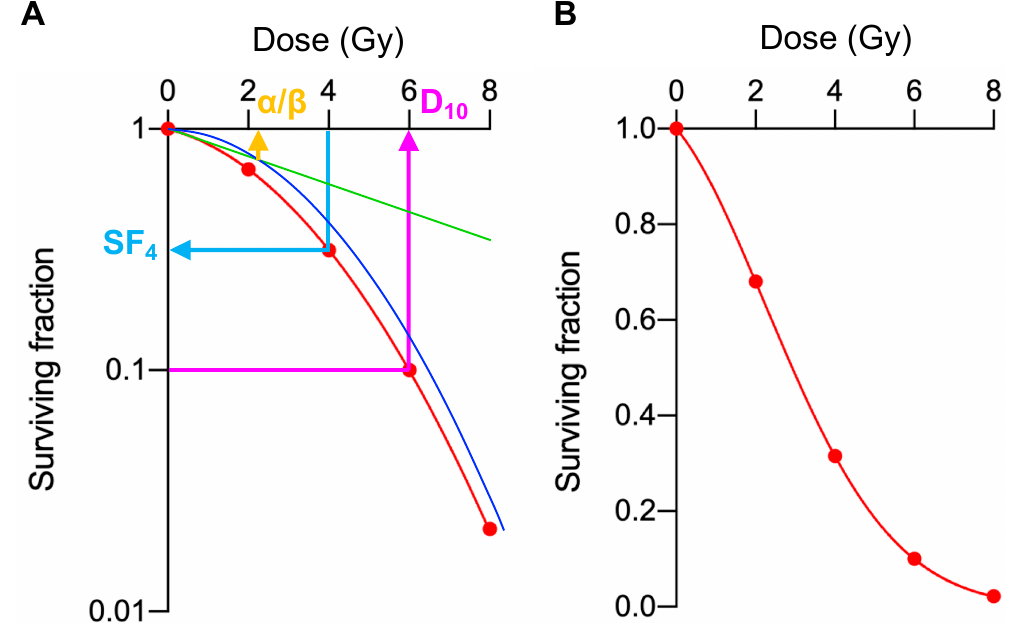
Figure 4. Exemplary presentation of the analyzed parameters for clonogenic survival. ( A ) Surviving fractions for the cells irradiated with 2, 4, 6, or 8 Gy (SF 2 , SF 4 , SF 6 , and SF 8 , respectively) are plotted on a semi-logarithmic-scaled graph (indicated as red dots). The survival data were fitted to the LQ model: S = exp( − ( α D + β D 2 )), where S is the surviving fraction and D is the dose (red line indicates the LQ curve; green and blue line indicates its linear and quadratic component, respectively). D 10 and D 50 are calculated from the LQ model formula, where D X indicates the dose that decreases the surviving fraction to X%. As an example, α / β (2.1), SF 4 (0.32), and D 10 (6.0) are shown as orange, light blue, and violet arrow, respectively. ( B ) The same exemplary survival data were plotted on a linear-scaled graph. MID equals the area under the curve (indicated as light red) [11].